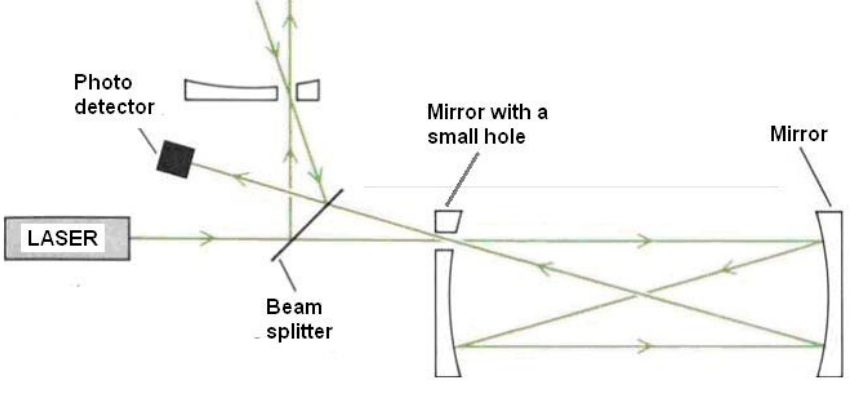
Figure 9. Optical delay method.